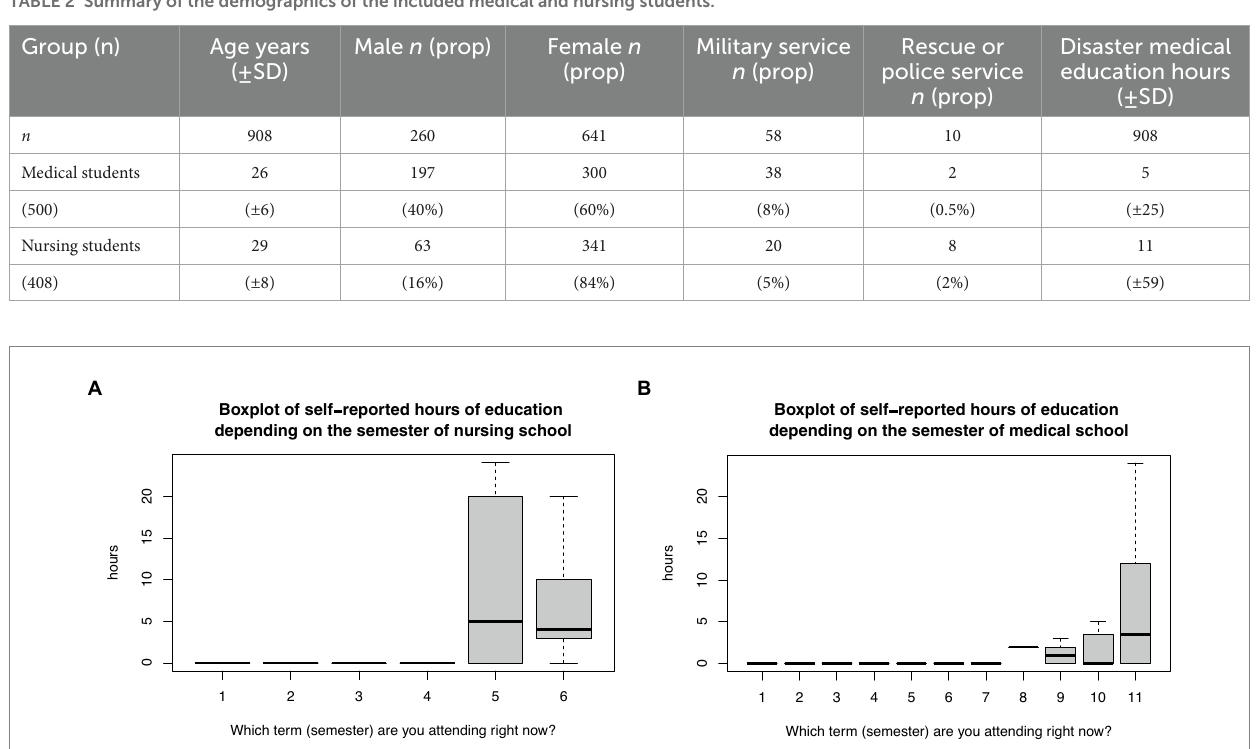
FIGURE 1 Boxplot of the self-reported hours of education in disaster medicine depending on the semester of (A) nursing and (B) medical